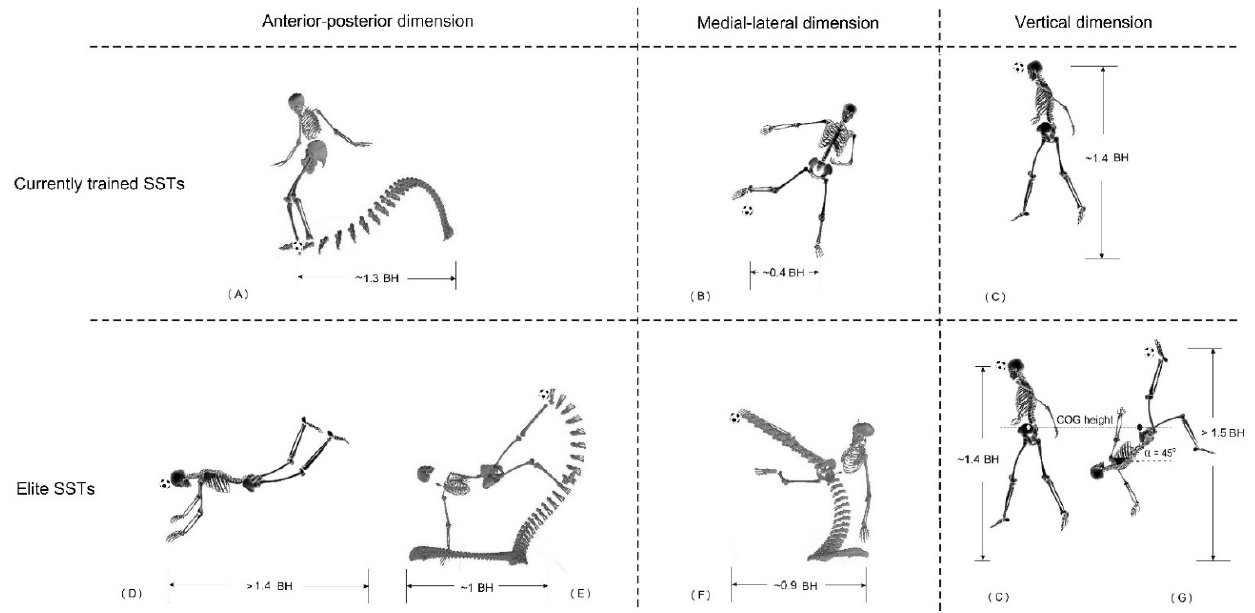
Figure 3. The dimensions of selected SSTs and their influences on the quantification of the attack space (scoring chance): ( A ) The 3D quantification of the maximal instep kick–side view with timely trace of the kicking foot, obtained via 3D-motion analysis and biomechanical modeling [52–54]. ( B ) Lateral dimension of volley kick–distance estimated using biomechanical modeling and anthropo- metrical study [5,56]. ( C ) Vertical dimension of a jumping header–distance estimated using jump biomechanics [57,58] and anthropometrical modeling [56]. ( D ) Frontal dimension of a diving header–distance estimated using diving biomechanics [59] and anthropometrical modeling [56]. ( E ) The 3D quantification of the bicycle kick–side view with timely trace of the kicking foot, obtained via 3D-motion analysis and biomechanical modeling [9,43,56]. ( F ) The 3D quantification of jumping side volley–frontal view with timely trace of the kicking foot, obtained via 3D-motion analysis and biomechanical modeling [4,43]. ( G ) Potential attack height reached by using a bicycle kick at different trunk-angle orientations–biomechanical model estimation